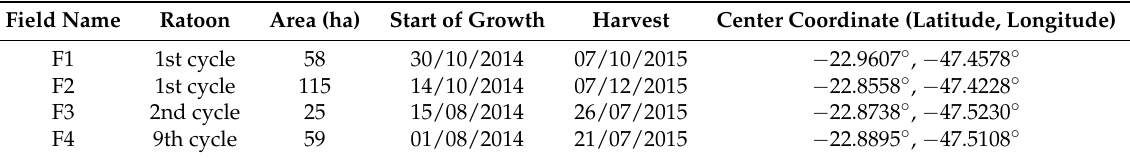
Figure 2. Location of the four fields of interest, indicated by red polygons, and weather stations, indicated by yellow stars. Table 1. Characteristics of the four sugarcane fields; growth and harvest dates are not applicable to the entire field for F1 and